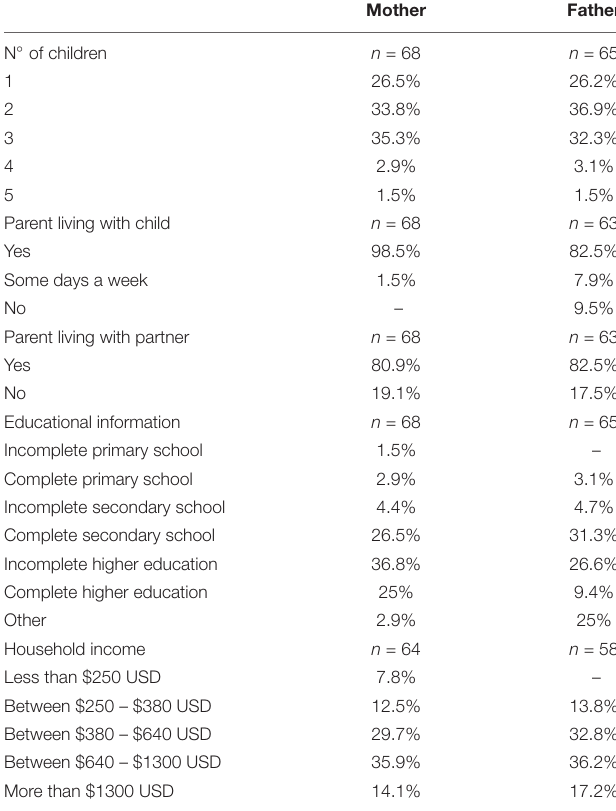
TABLE 1 | Sample demographic characteristics at